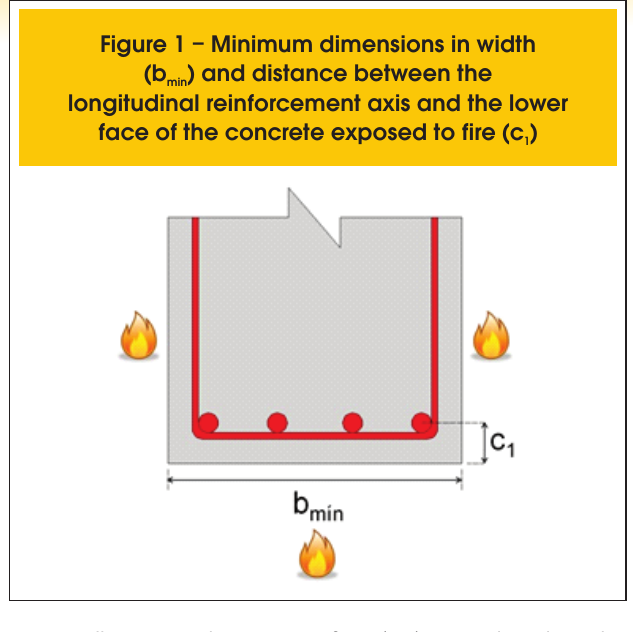
Figure 1 – Minimum dimensions in width (b ) and distance between the min longitudinal reinforcement axis and the lower face of the concrete exposed to fire (c )